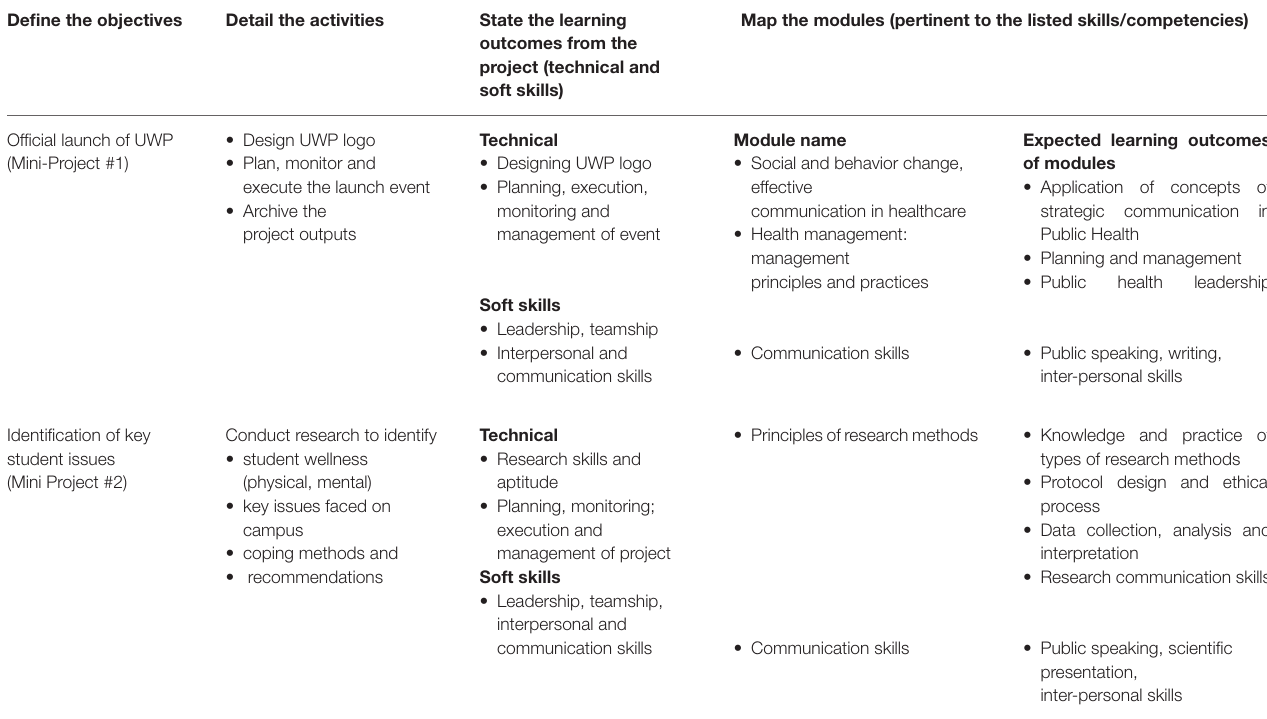
Map the modules (pertinent to the listed skills/competencies) outcomes from the project (technical and soft skills)